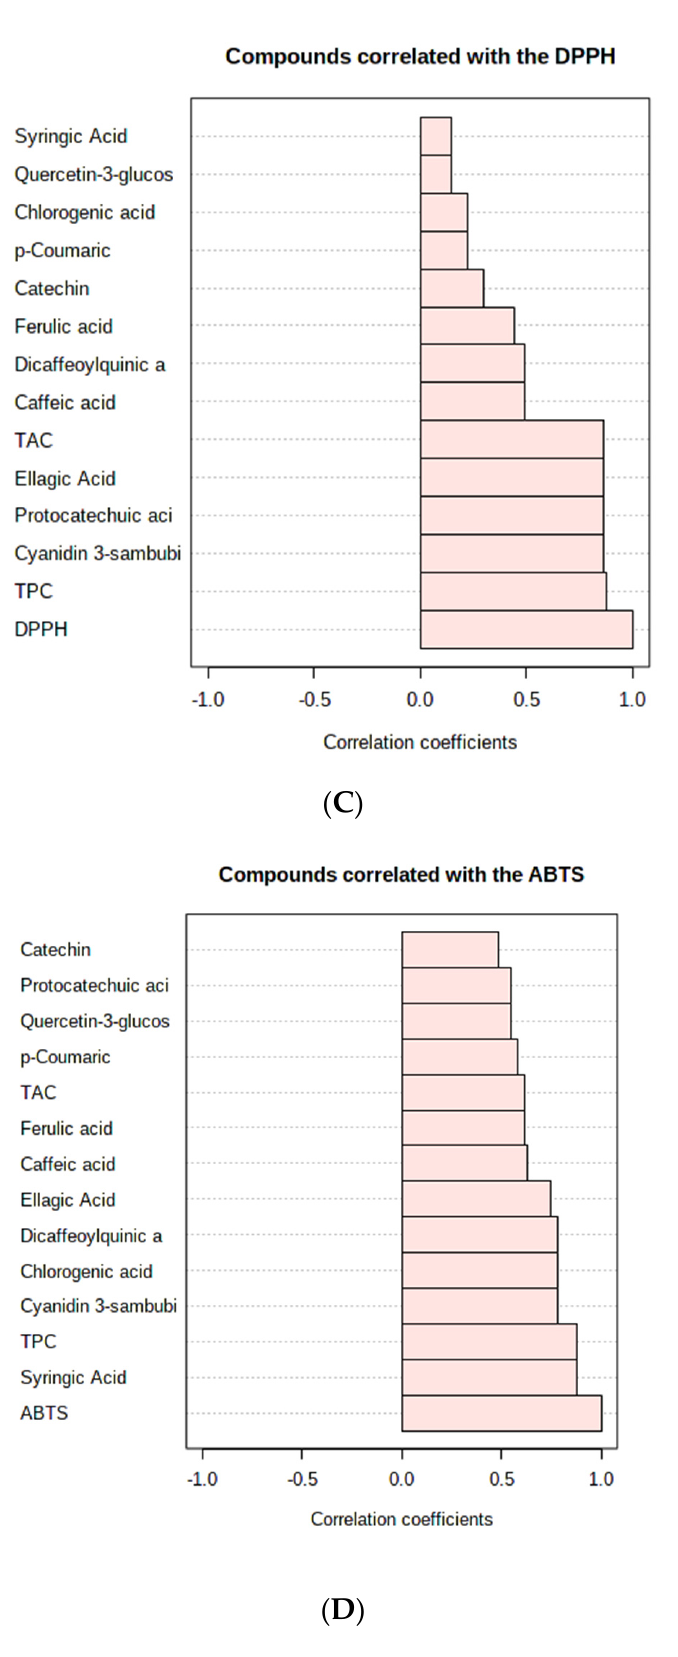
Figure 5. Correlation of total phenolic content ( A ), FRAP antioxidant capacity ( B ), DPPH ( C ) and ABTS ( D ) radical scavenging capacities with phenolic compounds.